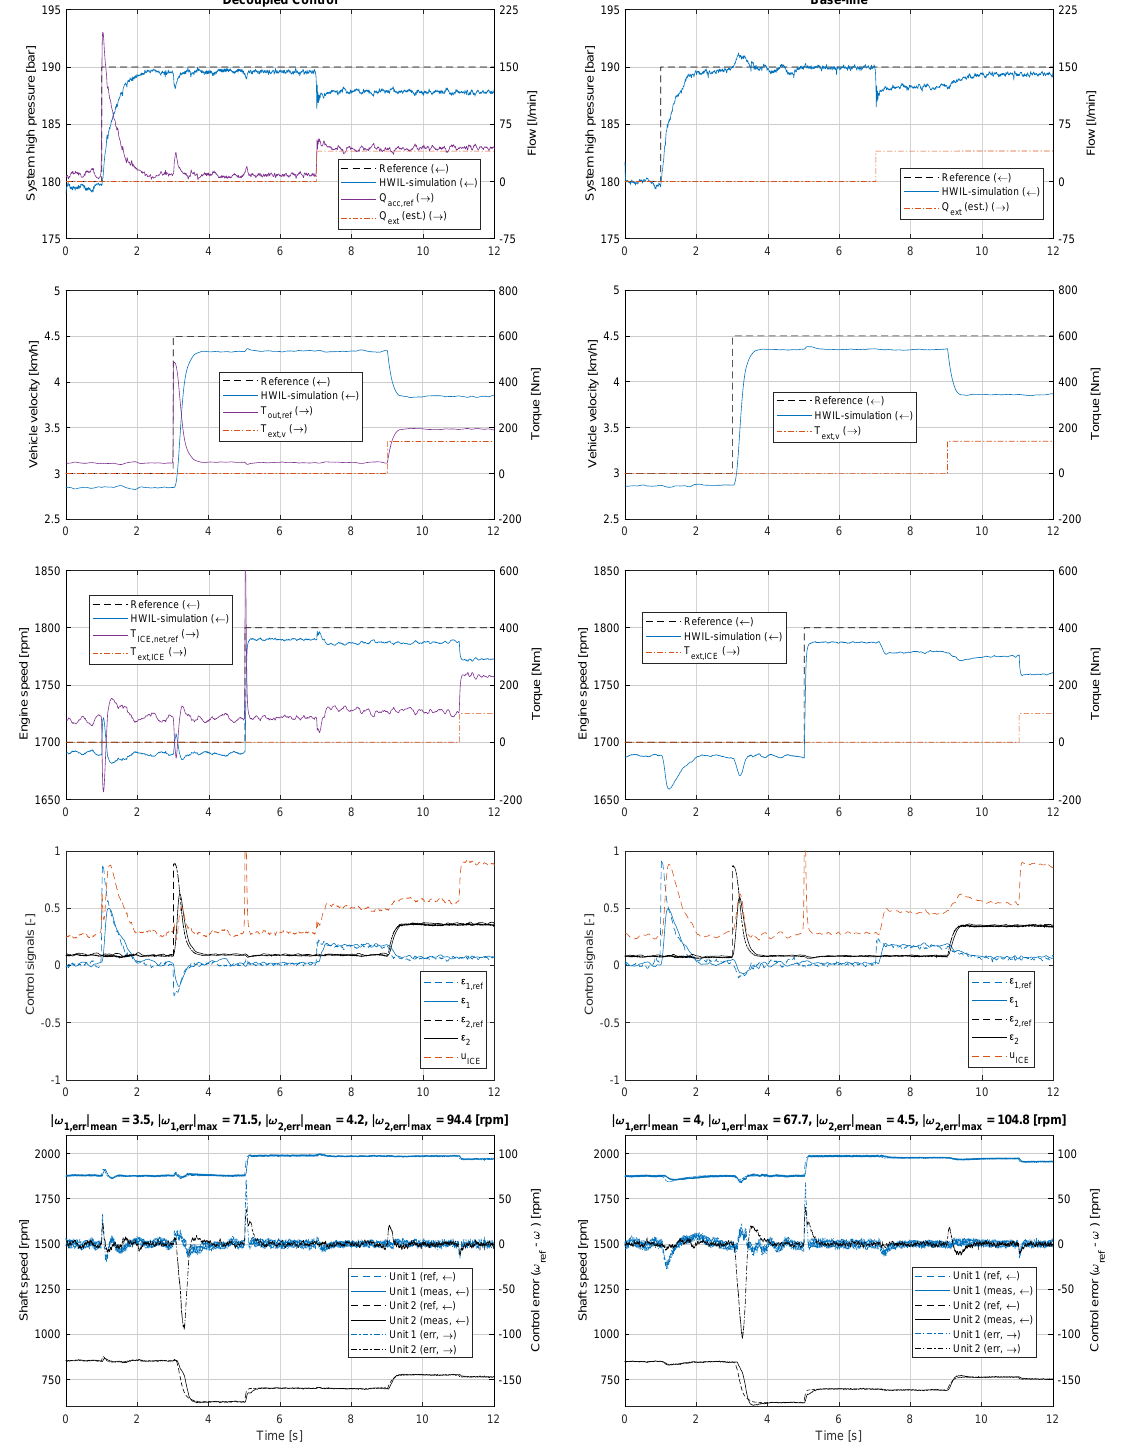
Figure 7. HWIL-simulation results of the step series cycle for decoupled (left column) and baseline (right column) control. Note that the bottom row shows the performance of the HWIL simulation controller and not the transmission control strategy. The output shaft speed has been scaled to vehicle (cid:16) (cid:17) ω out = v veh velocity via the wheel radius and final gear ratio . Q ext was estimated according to i 0 r w (cid:113) Q ext = u v , dist · 1.35 p sys · 10 − 5 , where a step of 2.15 V was made in u v , dist